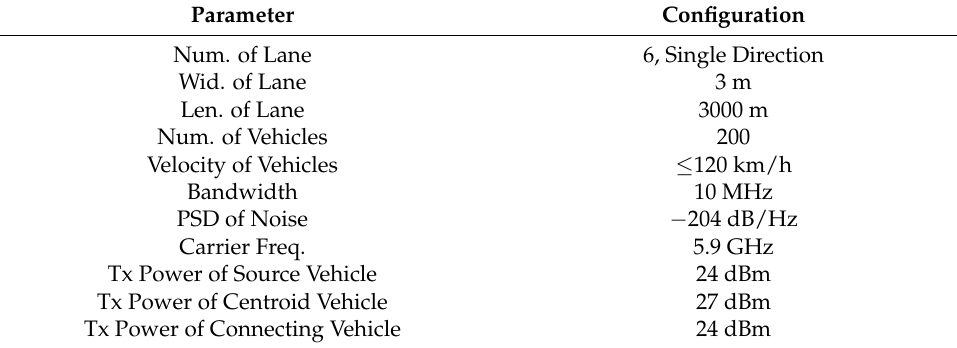
Figure 3. Matlab-NS3 files coordination. Table 1. Simulation-1 parameter settings.